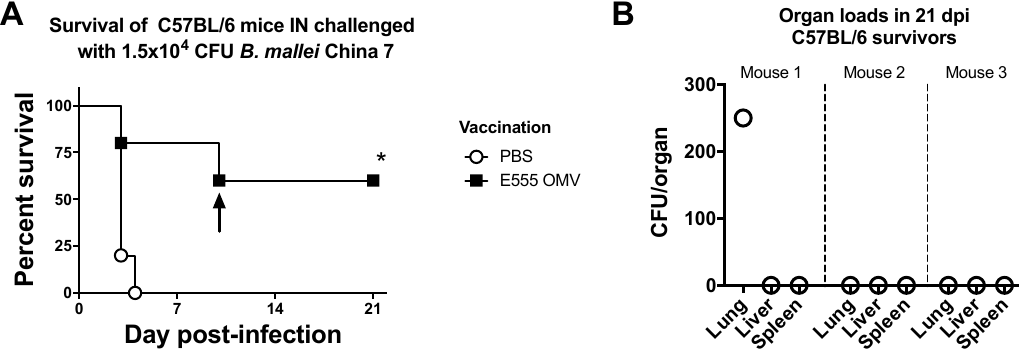
Figure 8. OMVs derived from B. thailandensis E555 protect C57BL/6 mice from acute lethal glanders and can provide sterilizing immunity following intranasal inoculation. ( A ) 4–6 weeks old C57BL/6 mice intranasally challenged with 1.5 × 10 4 CFU B. mallei China 7 after prime-boost-boost vaccination with E555-derived OMV or PBS (each group n = 5) were observed for survival out to 21 days. Statistically significant increases in survival compared to PBS vaccinated mice were determined by the Log-rank (Mantel-Cox) test where * p ≤ 0.05. Arrow indicates mouse was euthanized for neurological symptoms. ( B ) Organ loads of lungs, livers, and spleens of 21-day survivors showing sterilizing immunity in two mice and close to sterilizing immunity in the third.